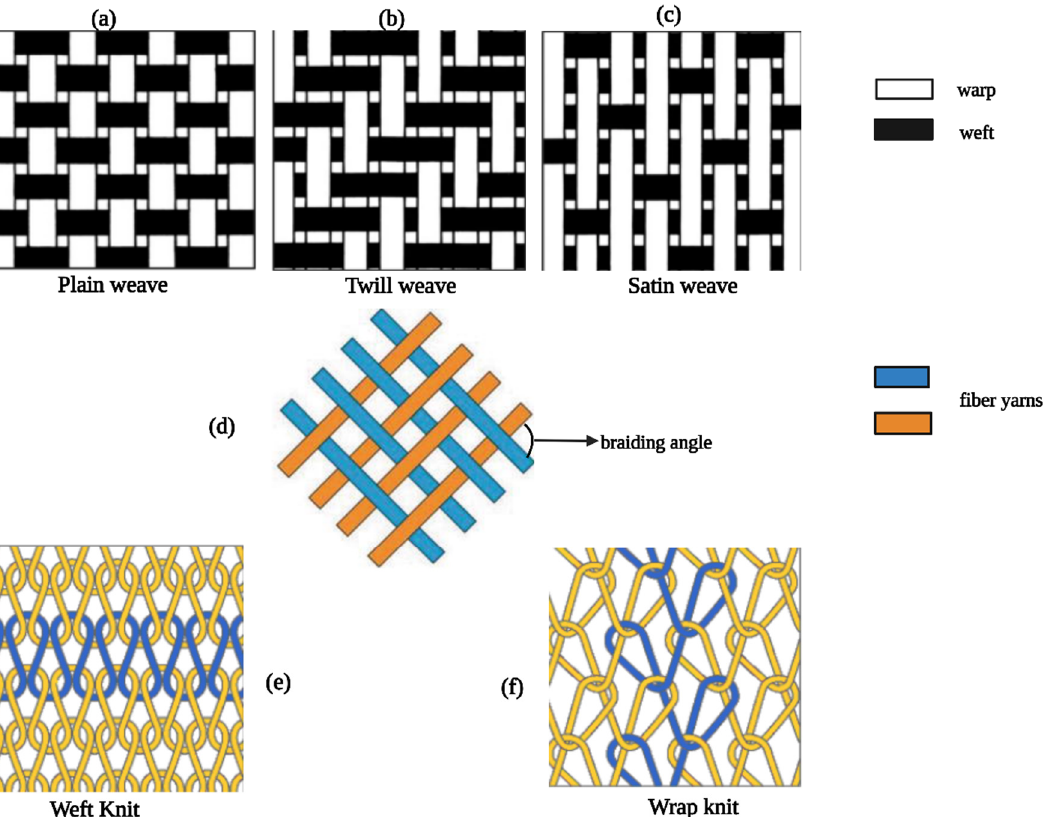
Figure 2. Design patterns of weaving/braiding/knitting. ( a – c ) are three types of weaving designs, ( d ) regular structure of braiding, and ( e , f ) are two types of knitting designs.